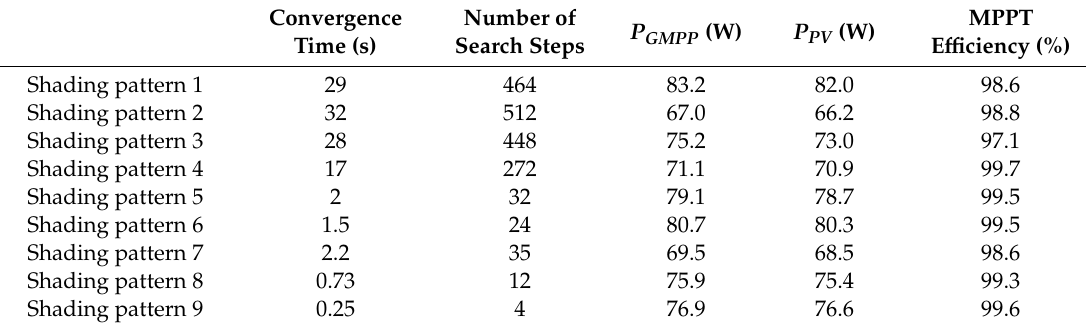
Table 5. The simulation results of the proposed Q-learning-based GMPPT method for various shading patterns.